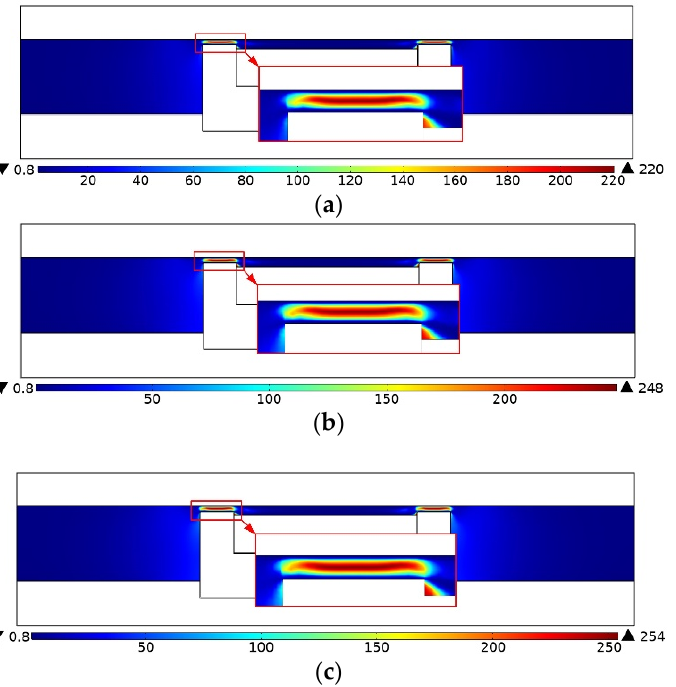
Figure 11. Dynamic viscosity distribution under different currents. ( a ) Current of 0.6 A, ( b ) current of 1 A, ( c ) current of 1.4 A.